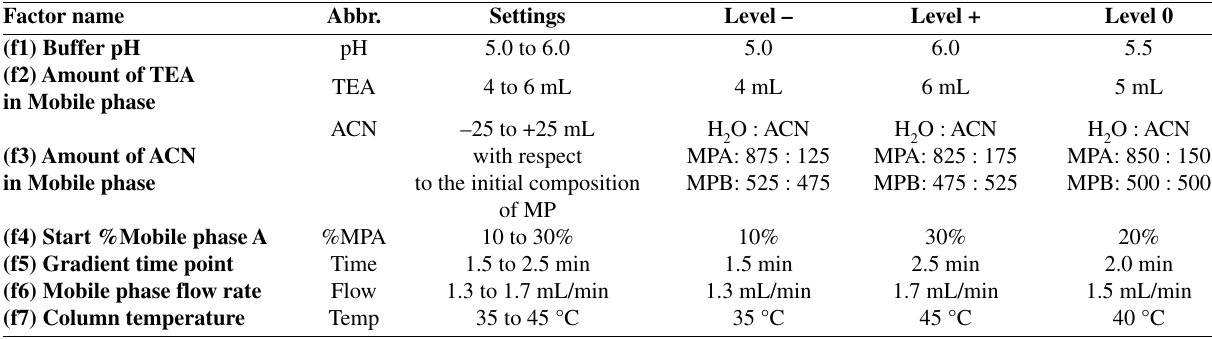
Table 2. Factors and corresponding levels for 2 7–3 fractional factorial